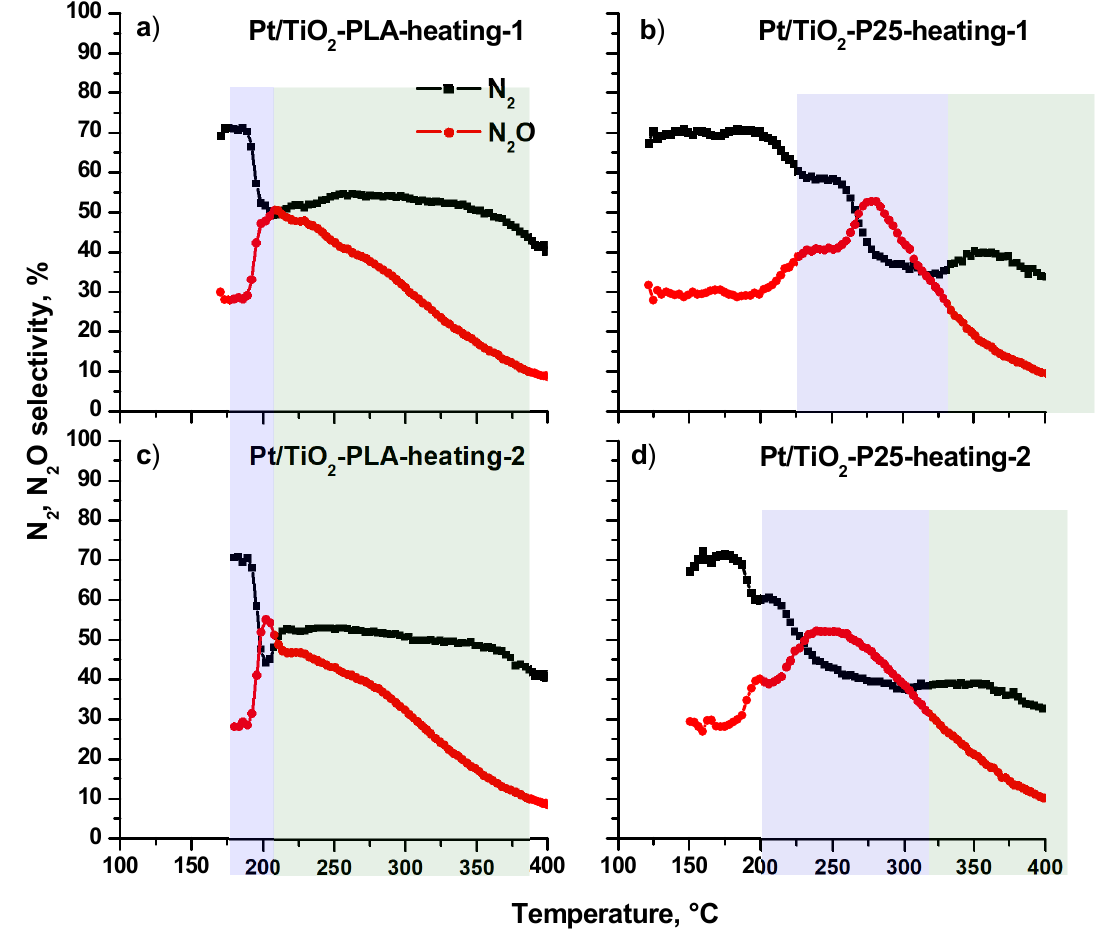
Figure A4. Selectivity for N 2 and N 2 O products depending on the NH 3 + O 2 reaction temperature during two heating cycles for the catalysts: ( a ) Pt/Ti-PLA-400; ( b ) Pt/Ti-P25-400. N 2 O selectivity was calculated based on the experimental measurements, N 2 selectivity was calculated by balance. The transition region from a high N 2 selectivity level is filled with blue; the region of low N 2 selectivity is marked with green color. Table A1. Structural characteristics of TiO 2 in Pt/Ti-PLA and Pt/Ti-P25 samples.